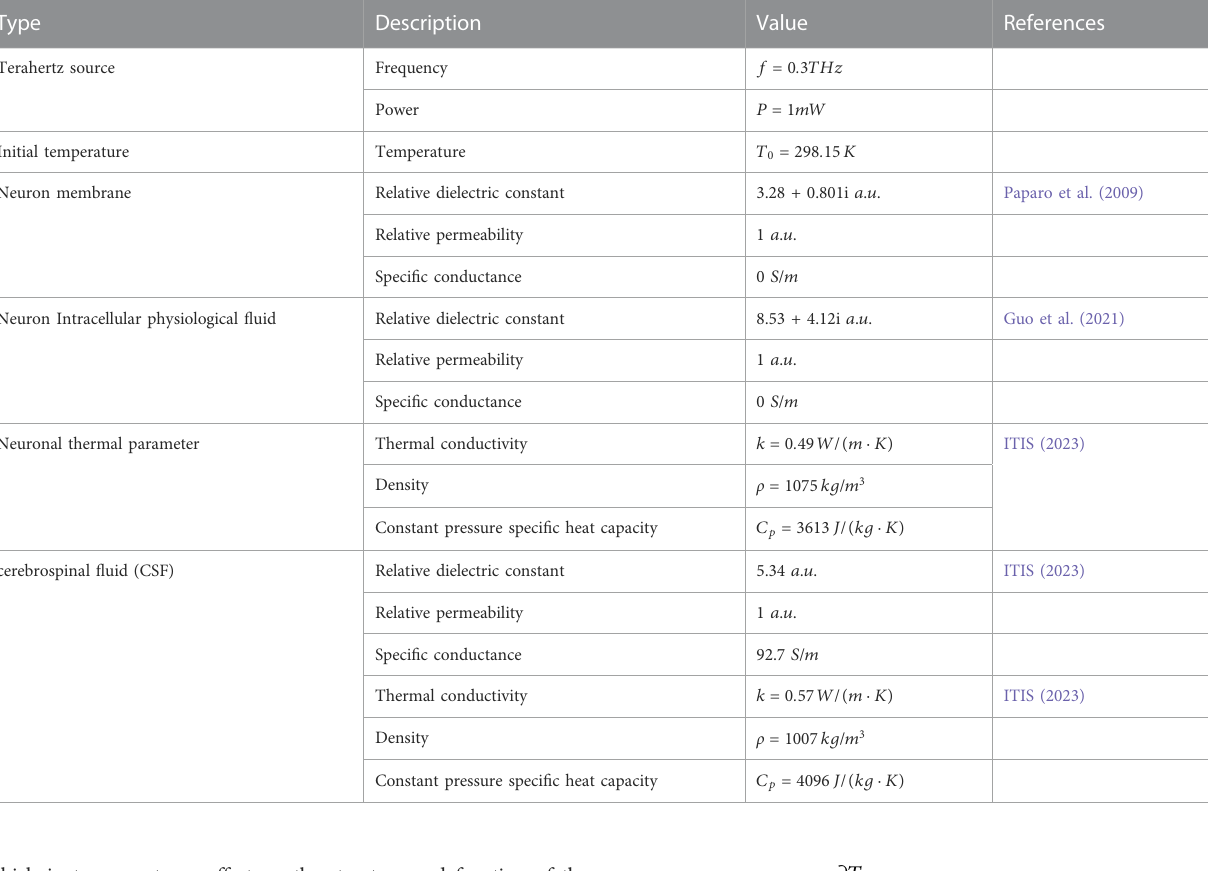
TABLE 3 The initial conditions for solving the equations and the properties of the materials.